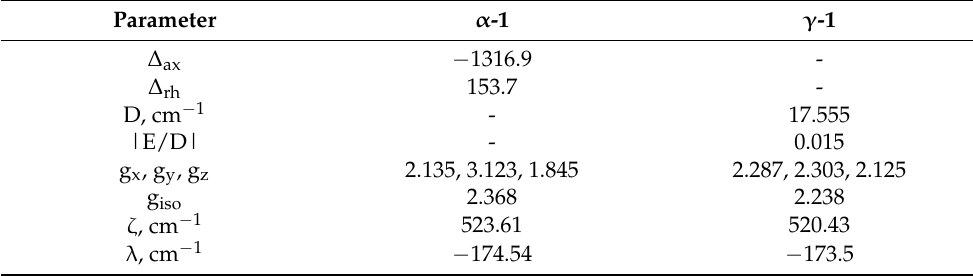
Table 4. The best-fit of the experimental magnetic data for α - 1 and γ - 1